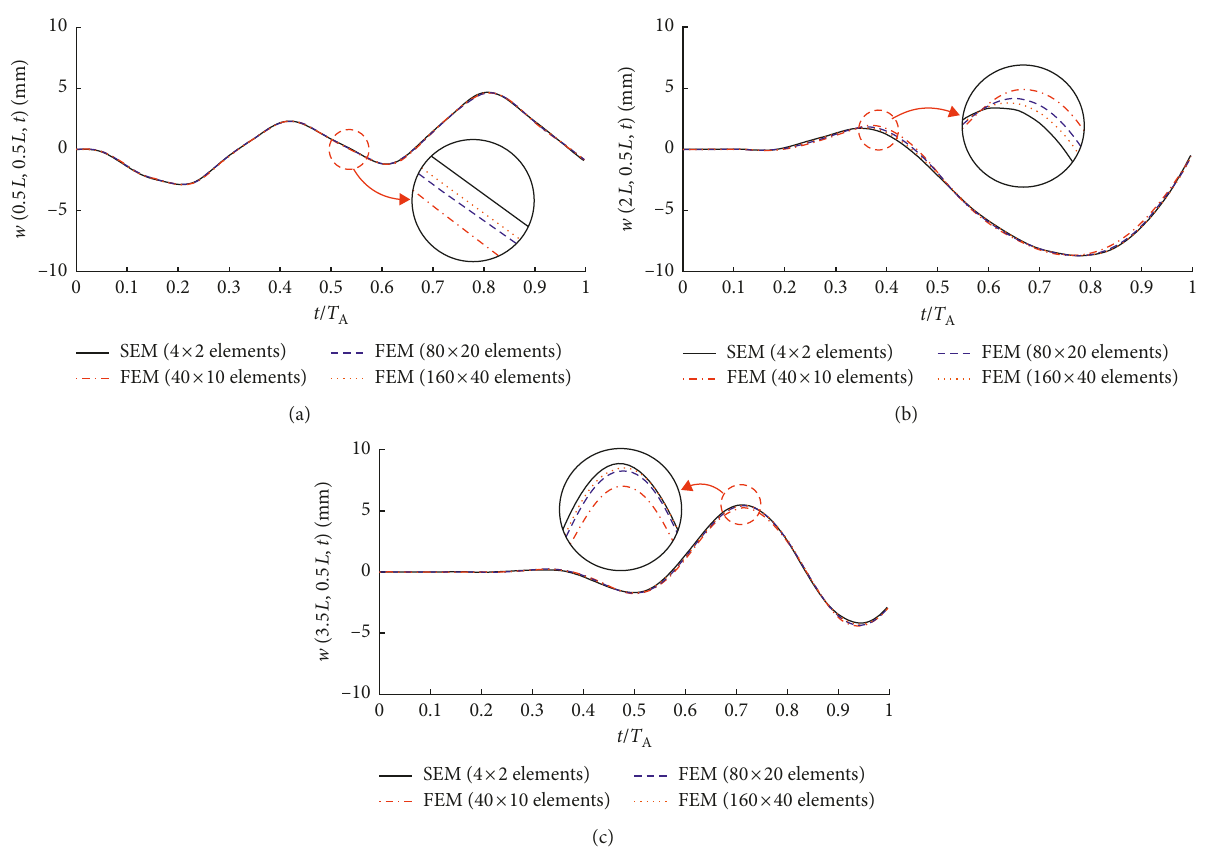
Figure 15: Comparison of the vibration responses obtained by the FEM [14] and SEM at three different locations of the S-S-S-S three-span rectangular plate (Example 4) subjected to a moving point force whose trajectory is given by (40), where v 0 (b) at X 2 L , Y 0.5 L , and (c) at X 3.5 L , Y 0.5 L (cid:31) (cid:31) (cid:31) (cid:31)